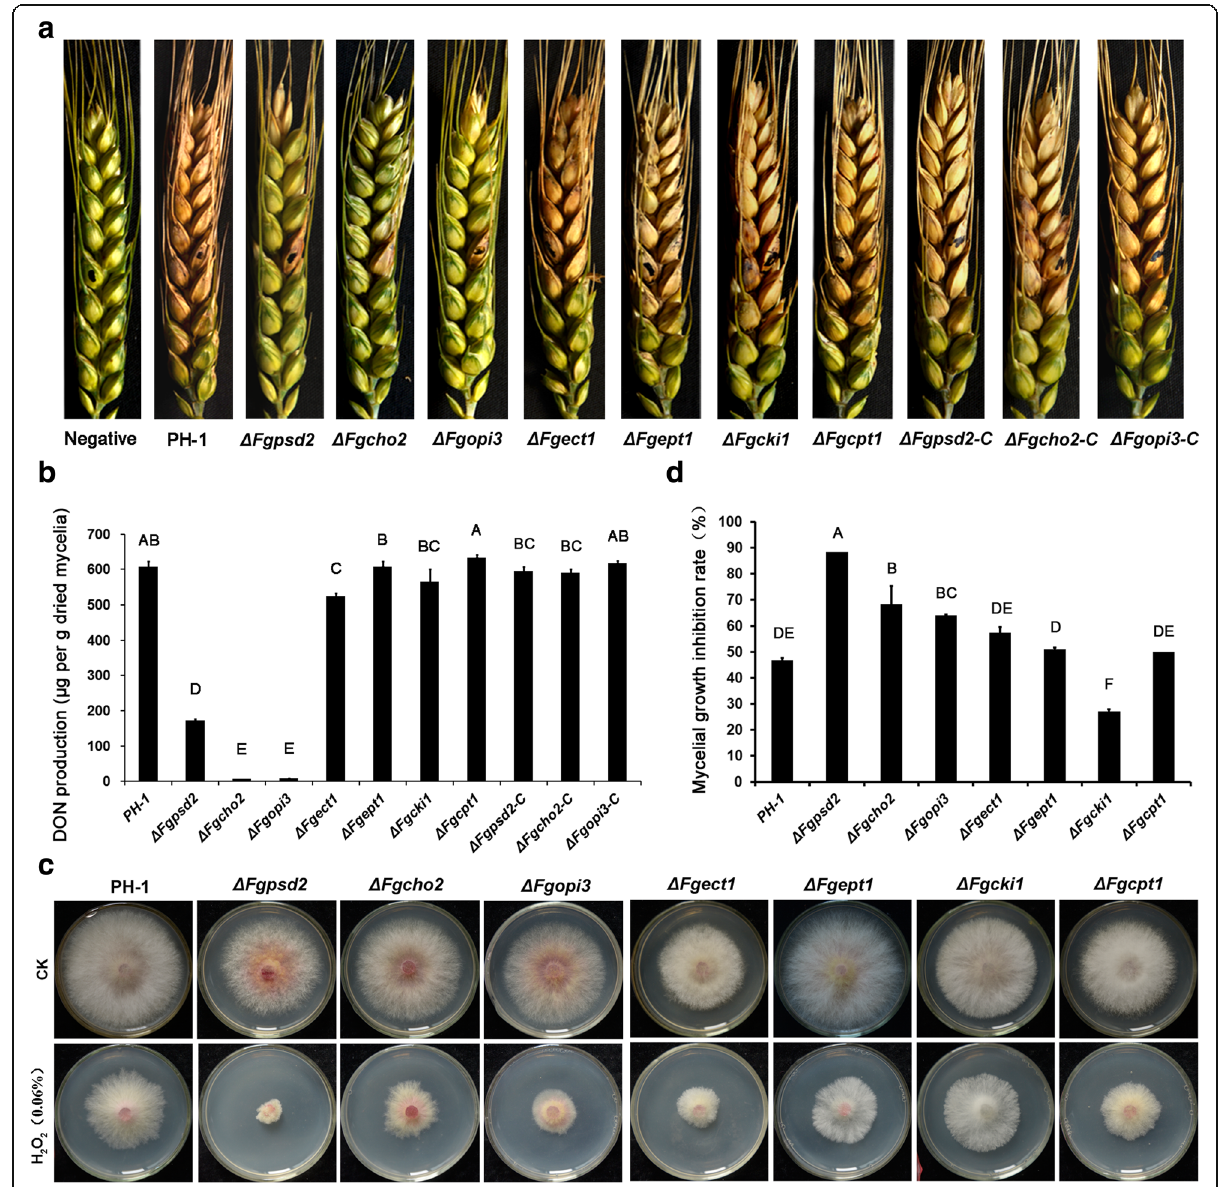
Fig. 5 Mutants of the de novo pathway of phospholipid biosynthesis exhibited attenuated virulence on wheat heads. a Infected wheat heads were examined 15 days after inoculation with a conidial suspension of each strain. The inoculation sites are indicated by the black dots. b Comparison of DON production between the wild-type strain and mutants after 7 days of incubation in the DON-inducing medium TBI. c Growth inhibition of the wild-type strain and mutants in response to H 2 O 2 . Strains were grown on CM amended with or without 0.05% H 2 O 2 . Images were obtained when the mycelia of the wild-type strain reached the edge of the plate. d Percentage of mycelial growth inhibition by 0.05% H 2 O 2 in each strain. The vertical lines on the bars in each column denote the standard deviations of three repeated experiments. The values corresponding to the bars denoted with the same letter are not significantly different according to the (LSD) test at P =